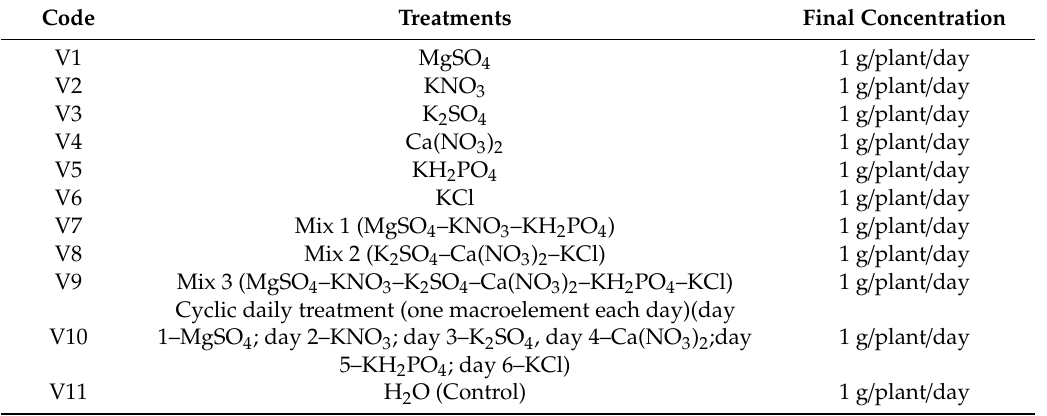
Table 1. Macronutrients treatment